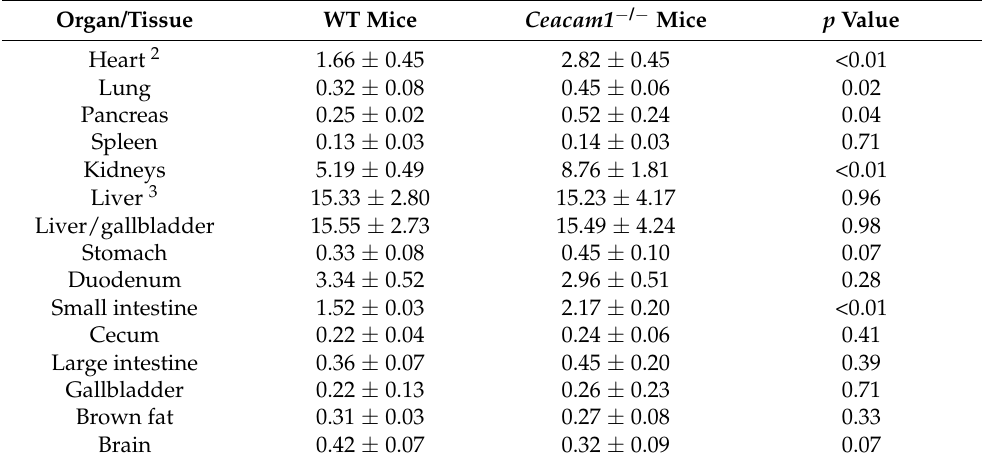
Table 1. Organ biodistribution (% dose/organ) of [ 18 F]FTO in WT mice and Ceacam1 − / − mice 1